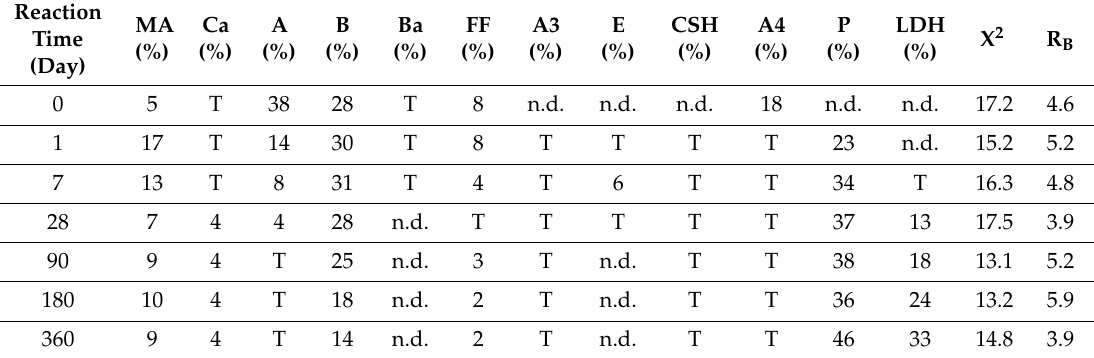
Table 5. Quantification Rietveld by anhydrous CPO and at 1, 7, 28, 90, 180, and 360 days (R B and X 2